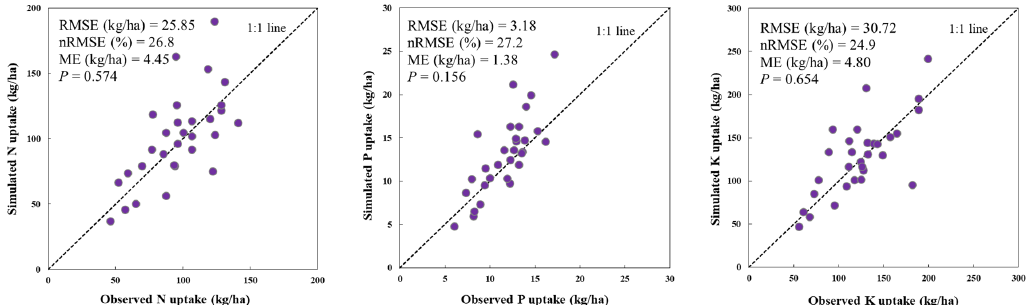
Figure 5. Relationships between observed and simulated N, P, and K uptake in the shoot dry matter for watermelons in Hebei province, China. The observed data were obtained from field experimental plots where the Nutrient Expert (NE) decision support system was applied. The simulated nutrient uptake data were estimated using the QUEFTS model. The dotted line represented the 1:1 line.